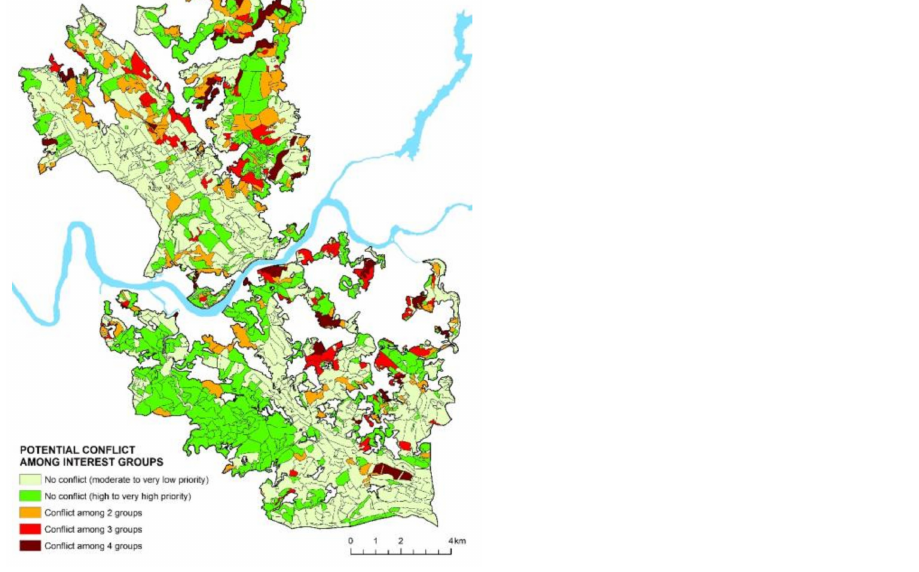
Figure 9. Most meaningful differences in priority scores of the allocation of the ecosystem